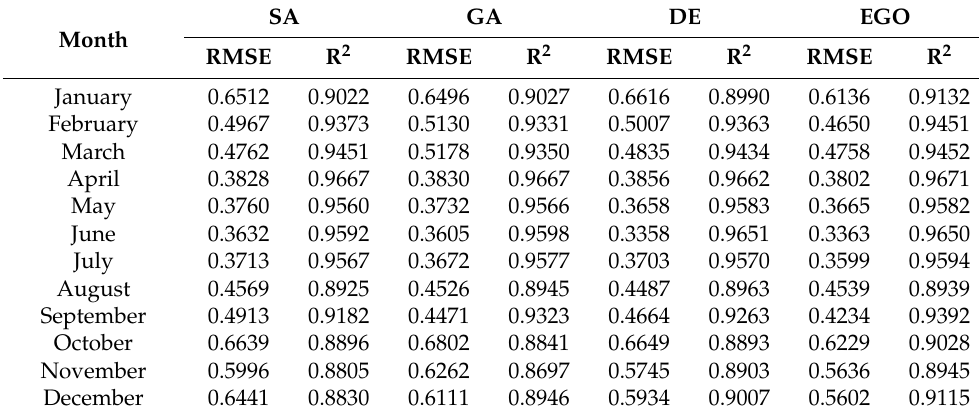
Table 5. Performance comparison based on different metrics.